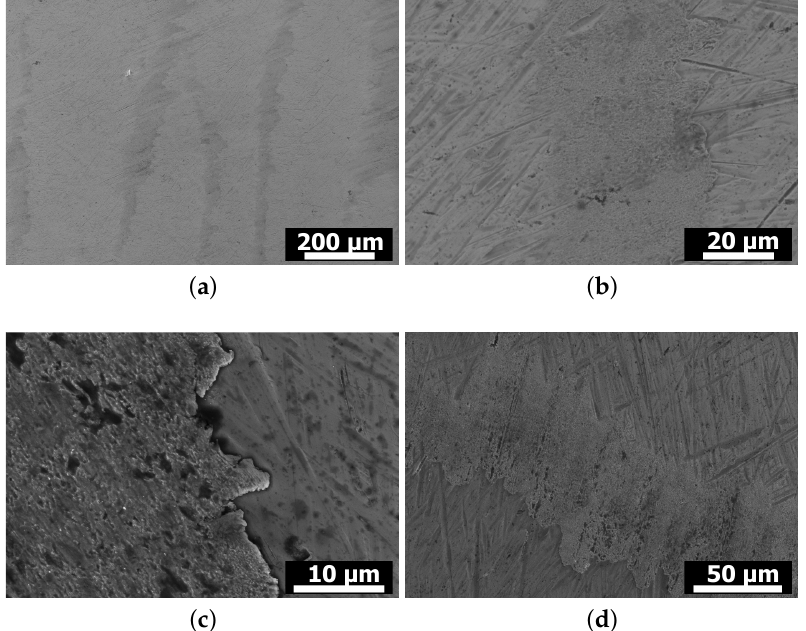
Figure 14. SEM images of worn disc surfaces after wear tests against ( a – c ) 10.4% Si FS pin and against ( d ) 6.6% Si FS